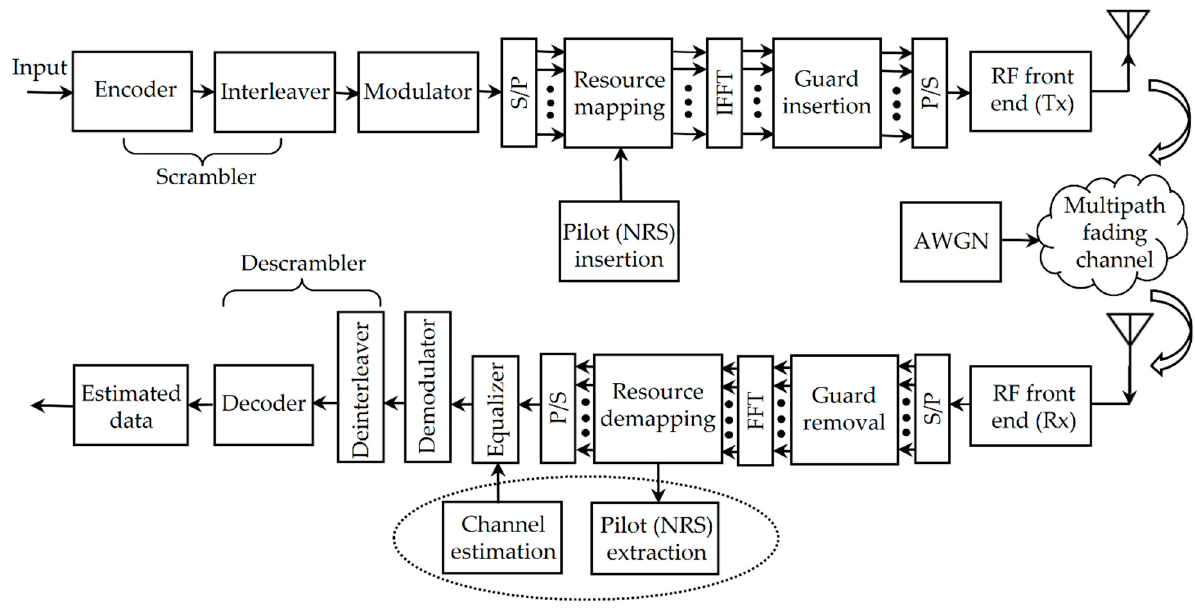
Figure 3. Block diagram of NB-IoT downlink transmission scheme.